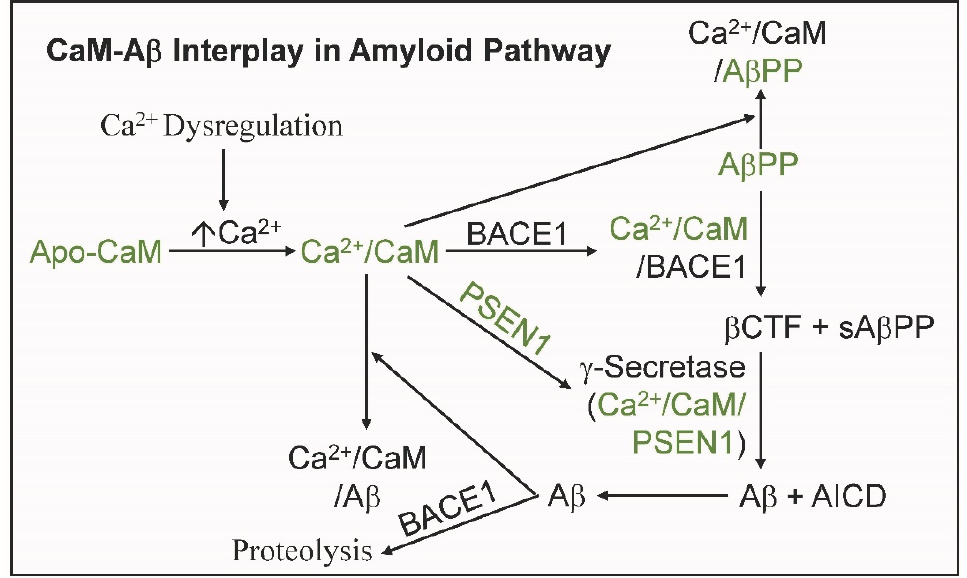
Figure 2. The interplay between calmodulin (CaM) and amyloid beta (A β ) in the amyloid pathway. Calmodulin (CaM) and its binding proteins that bind to A β are shown in